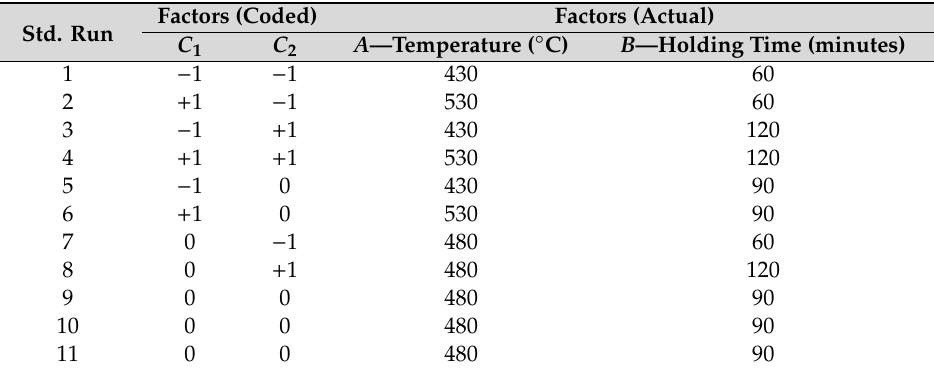
Table 5. Design of experimental matrix in hot press forging